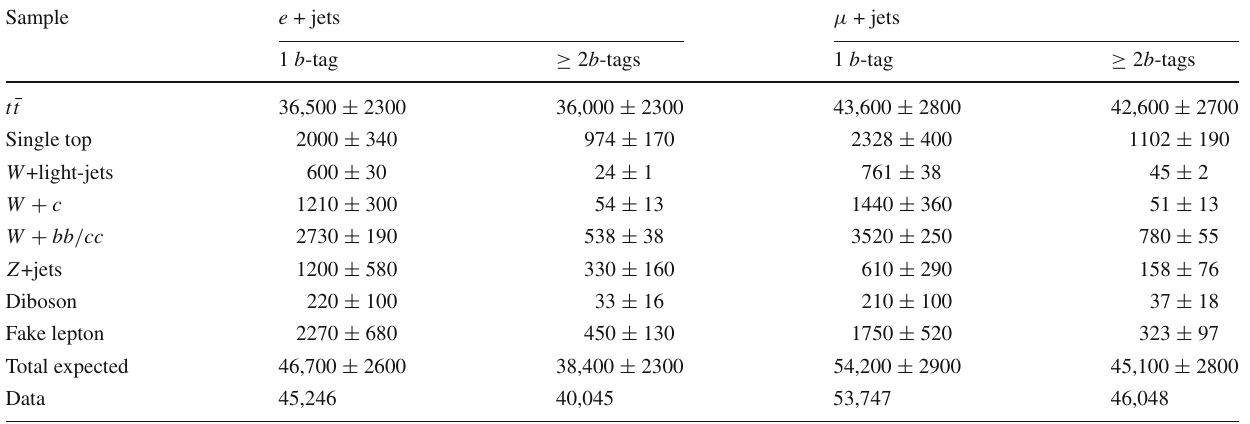
Table 1 Expected and observed event yields in the four channels (“ e +jets, 1 b -tag”, “ e +jets, ≥ 2 b -tags”, “ μ +jets, 1 b -tag” and “ μ +jets, ≥ 2 b -tags”)afterthefinaleventselectionincludingthecutontherecon- struction likelihood. Uncertainties in the normalisation of each sam-